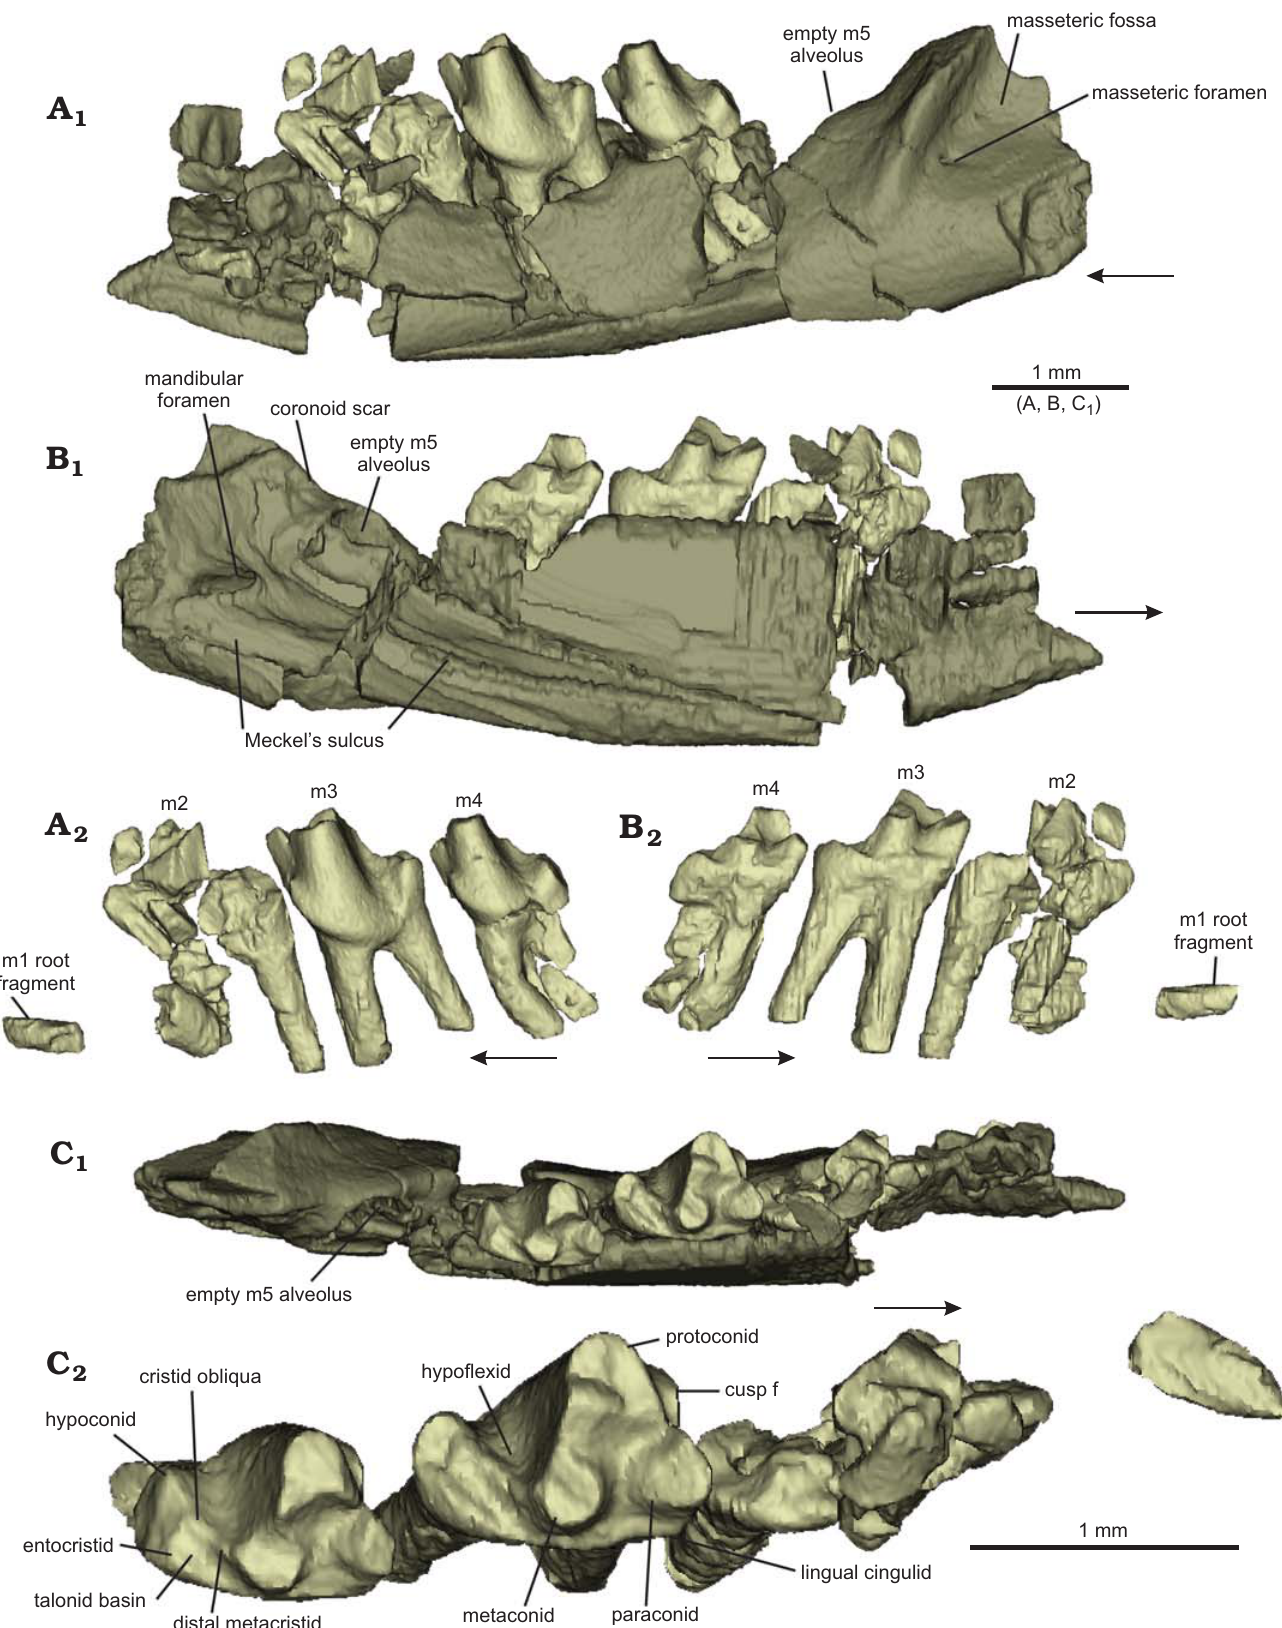
Fig. 2. Amphitheriid mammalian Palaeoxonodon ooliticus Freeman, 1976b (NMS G.2017.37.1) from the Kilmaluag Formation, Bathonian, in lingual ( A ), buccal ( B ), and occlusal ( C ) views; partial left dentary (A 1 –C 1 ), dentition only (A 2 –C 2 ). Arrows indicate anterior